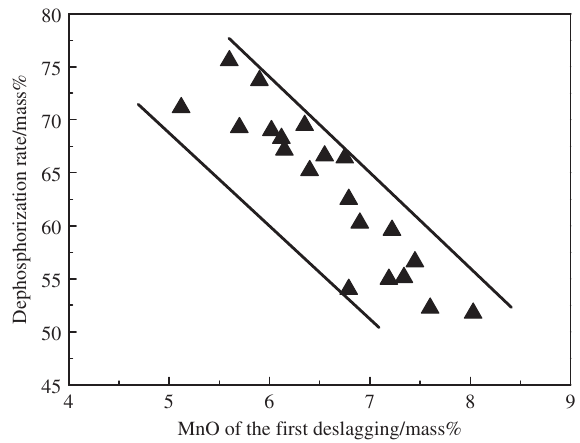
Figure 11: Effect of the MnO content in slag at the first deslagging on the phosphorus content in bulk